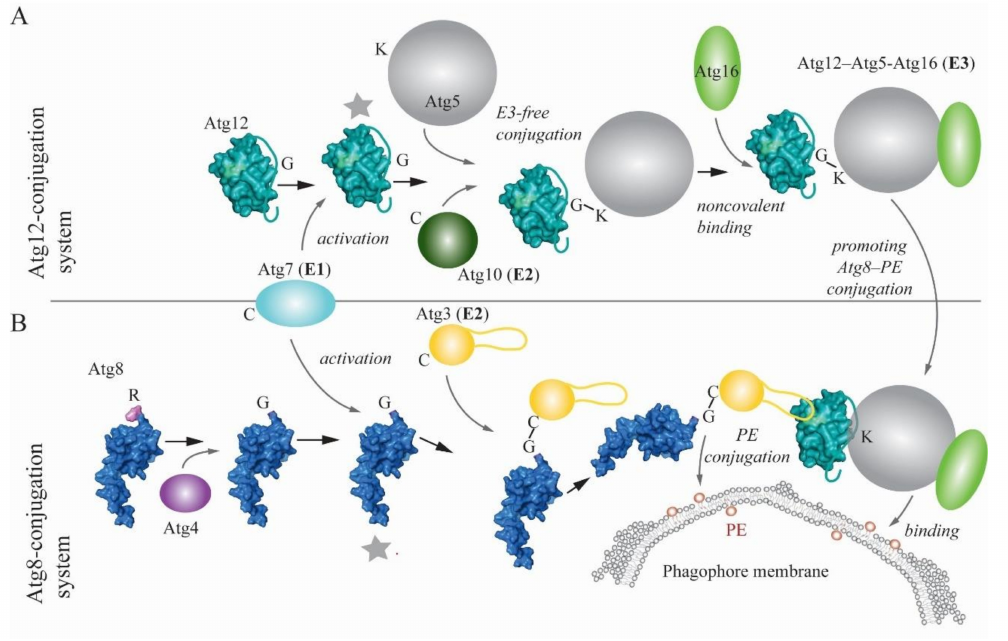
Figure 1. Schematic representation of the Atg8- and Atg12-conjugation systems in yeast. ( A ) Atg12 is activated by Atg7, the E1-like (activating) enzyme, and then transferred to Atg10, the E2-like (conjugating) enzyme. The Atg12–Atg10 intermediate interacts with Atg5, where the conserved lysine residue is covalently conjugated to the Atg12 C terminus in the E3-free (ligase) reaction. The Atg12–Atg5 binds noncovalently to Atg16. The resulting Atg12–Atg5-Atg16 complex acts as the E3-like enzyme in the Atg8–PE conjugation reaction. ( B ) Atg8 enters the conjugation reaction unprimed, due to the presence of a C-terminal arginine. Atg4 primes Atg8 by removing this last residue, leaving a C-terminal glycine exposed. As in the case of Atg12, Atg7 activates the Atg8 ubiquitin-like (UBL) domain by C-terminal adenylation, and then transfers Atg8 to the catalytic cysteine in the active site of Atg3. The Atg12–Atg5-Atg16 complex (E3-like) interacts with the Atg8~Atg3 intermediate, where a long flexible loop of Atg3 binds to a hydrophobic cavity on the surface of Atg12. This interaction enhances ligation of the C-terminal Gly in Atg8 to PE on the phagophore membrane. Atg8 and Atg12 are visualized using the crystal structures PDB ID: 2KQ7 and PDB ID: 3W1S, respectively. Gray stars denote activated states of